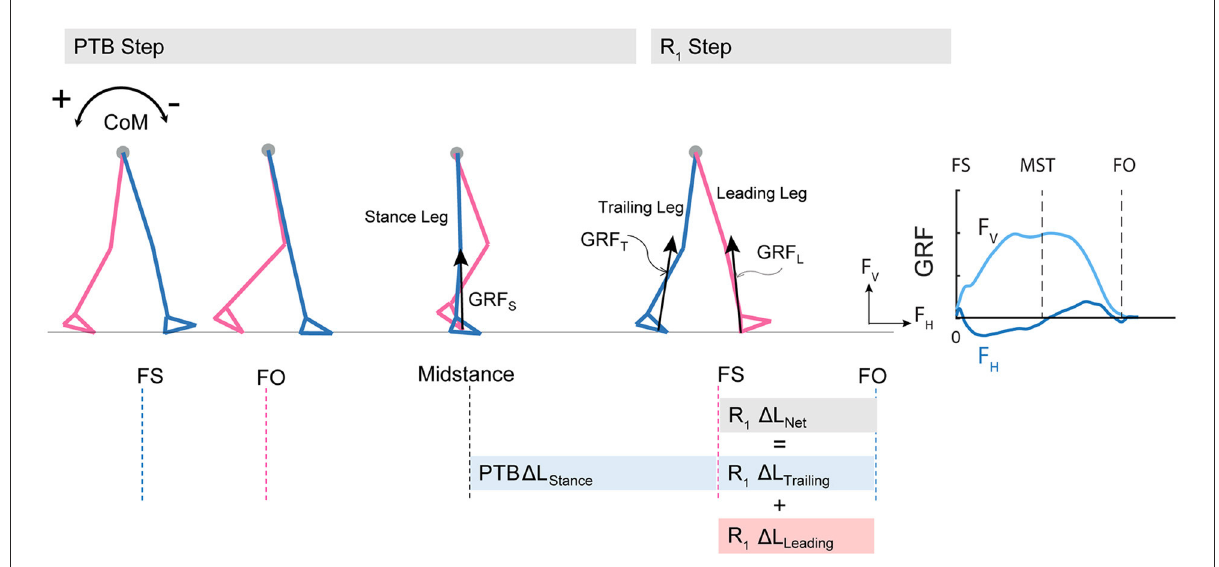
FIGURE2 Diagram of computed angular impulse about the body CoM by the leading and trailing leg during the perturbation (PTB) step and the first recovery step (R1) and illustration of ground reaction force from foot-strike to foot-off during one example perturbation step. The forward pitch impulse (PTB 1 L Stance ) is computed during the phase from midstance of the PTB step until the foot strike of the R 1 step. Net angular impulse (R 1 1 L Net ) is computed as the sum of trailing limb angular impulse (R 1 1 L Trailing ) and leading limb angular impulse (R 1 1 L Leading ) during the double support phase of the R 1 step. FS, Foot strike; FO, Foot-off; MST, Midstance. The arrows ( moments by the GRF about CoM, respectively. F v , vertical ground reaction force; F H , fore-aft ground reaction